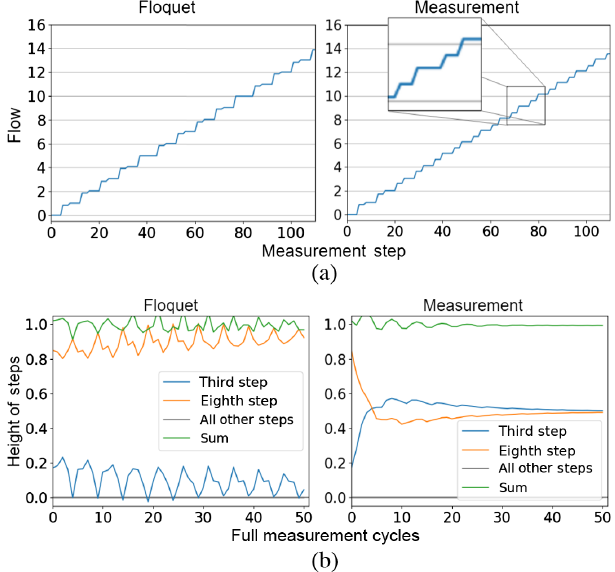
FIG. 8. (a) Charge transfer for Floquet system (left) and measurement protocol in the Zeno limit (right) where, in both cases, the hopping probability p ¼ 0 . 96 . (b) Charge transfer after each measurement step for the Floquet system and measurement protocol with hopping probability p ¼ 0 . 96 . Note the conver- gence of the third and eighth step to half the total flow per